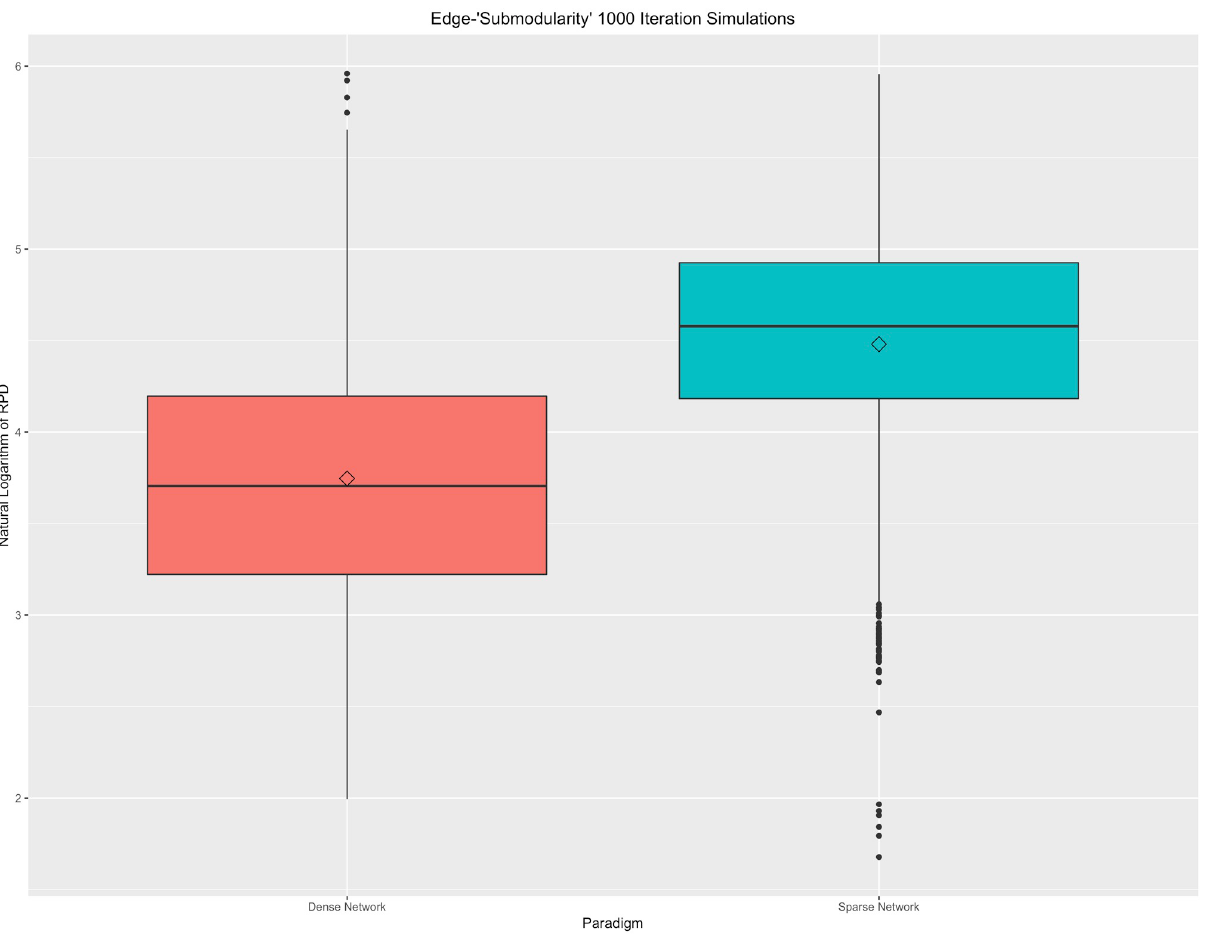
Fig 4. Edge-“submodularity” property. Boxplot of 1000 iterations under sparse and dense graph paradigms. A natural logarithm transformation has been applied to all resistance perturbation distance values for this figure. Random deletions from dense graphs, on average, result in smaller RPDs than in comparable sparse